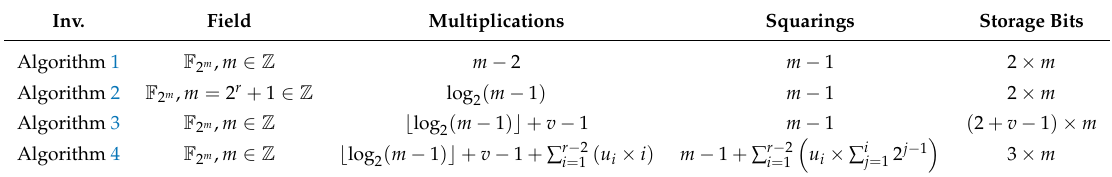
Table 1. Inversion algorithms cost over binary fields of variable length. Let v = HW ( m − 1 ) and u 1 . . . u i the binary representation of m , where HW ( w ) represents the Hamming weight of w . Inv.